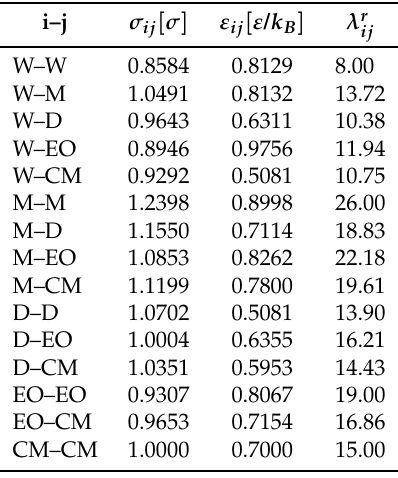
Table 3. Mie interaction potential parameters in reduced units. λ a energy units are σ = 0.43635 nm and ε / k B = 492 K, respectively. Therefore, k B T / ε = 0.6057, which corresponds to 25 ◦